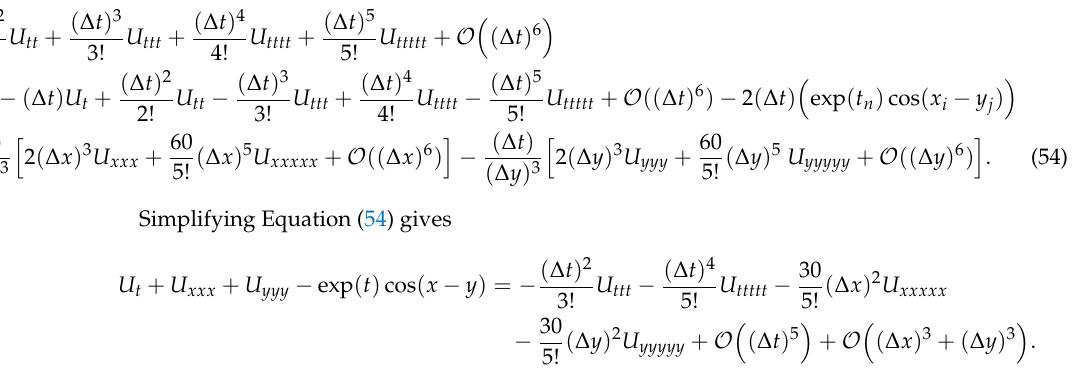
Thus, the scheme is consistent with the PDE in (12) and is second-order accurate in time and space. Figure 18 shows plots of the maximum error vs. time and the loglog plot of the maximum error vs. time using the classical FDM for Experiment 4.